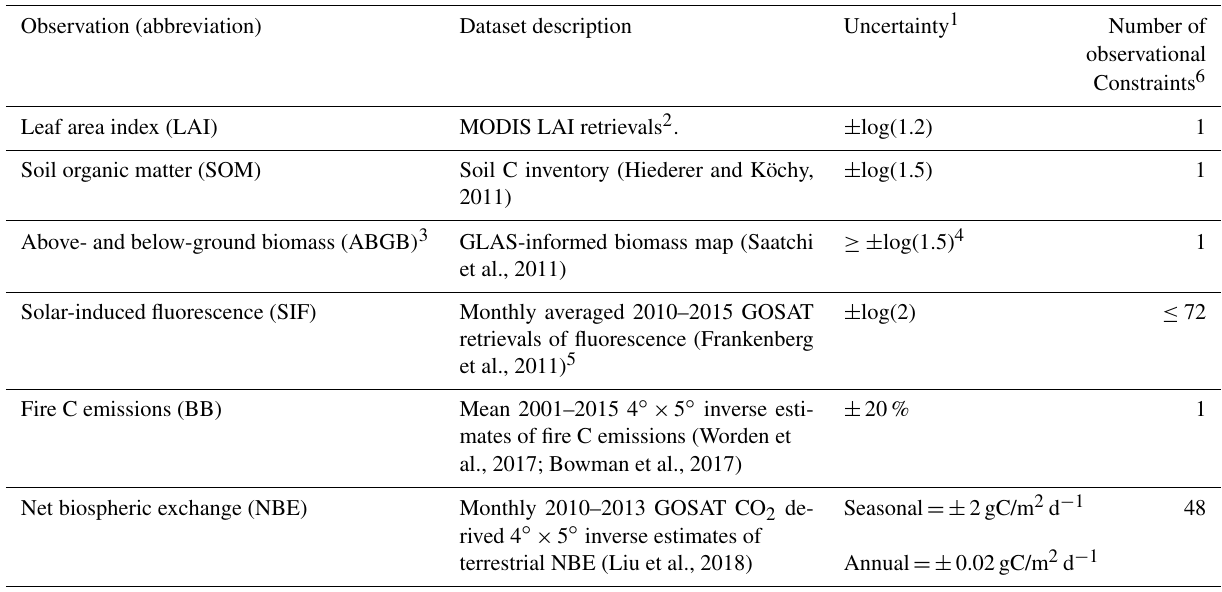
Table 1. Observational constraints assimilated into the 4 ◦ × 5 ◦ CARDAMOM simulation. Observation